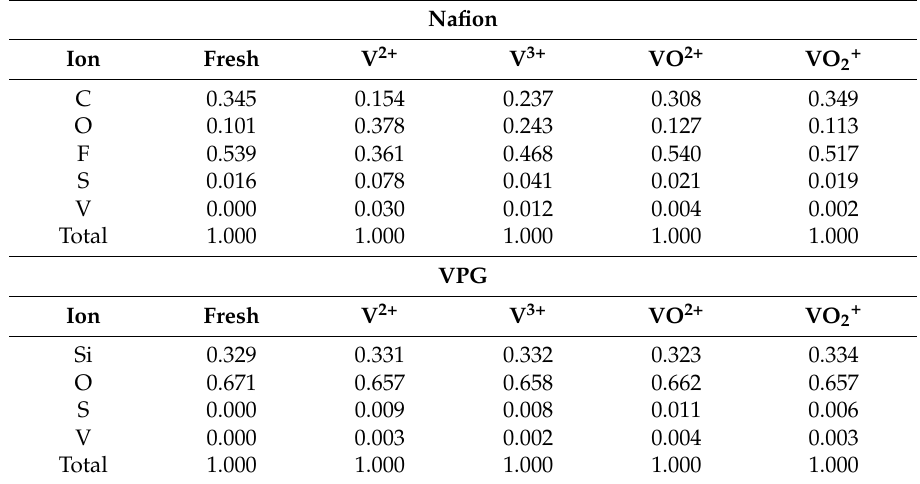
Table 2. Atomic compositions of the Nafion and VPG membrane surfaces measured by EDS for